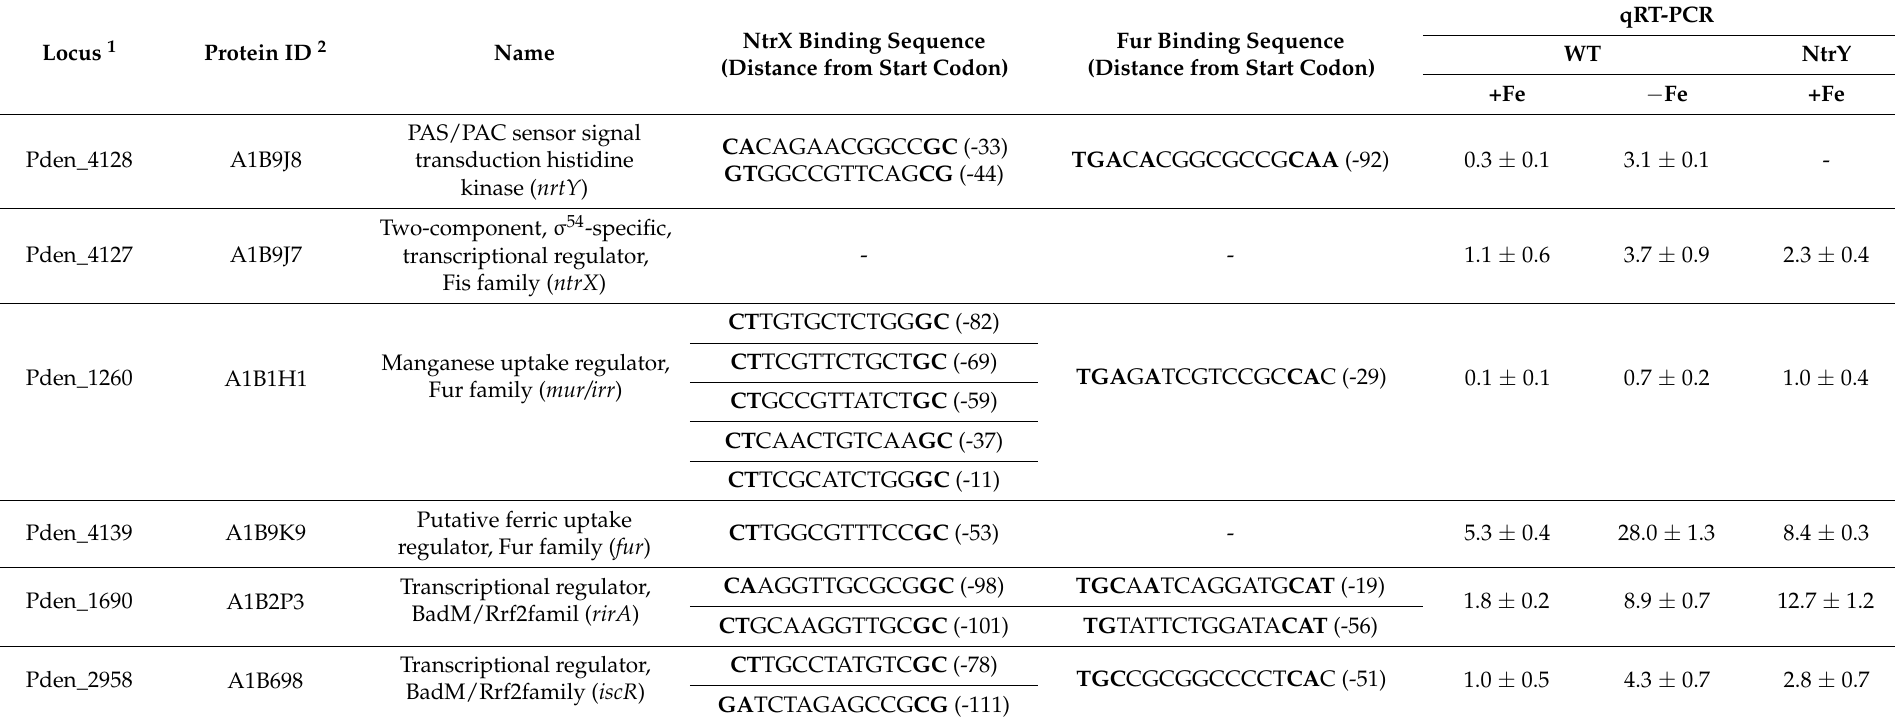
Table 1. Transcriptional analysis by qRT-PCR of putative iron-responsive regulators of P. denitrificans